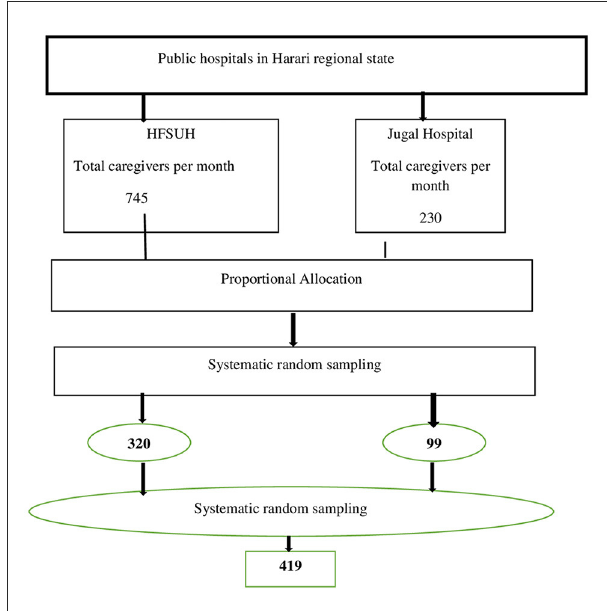
FIGURE1 The schematic presentation of the sampling procedure for the study on magnitude of perceived stigma and CMD and associated factors among caregivers of patients with mental illness attending public hospitals of Harari regional state